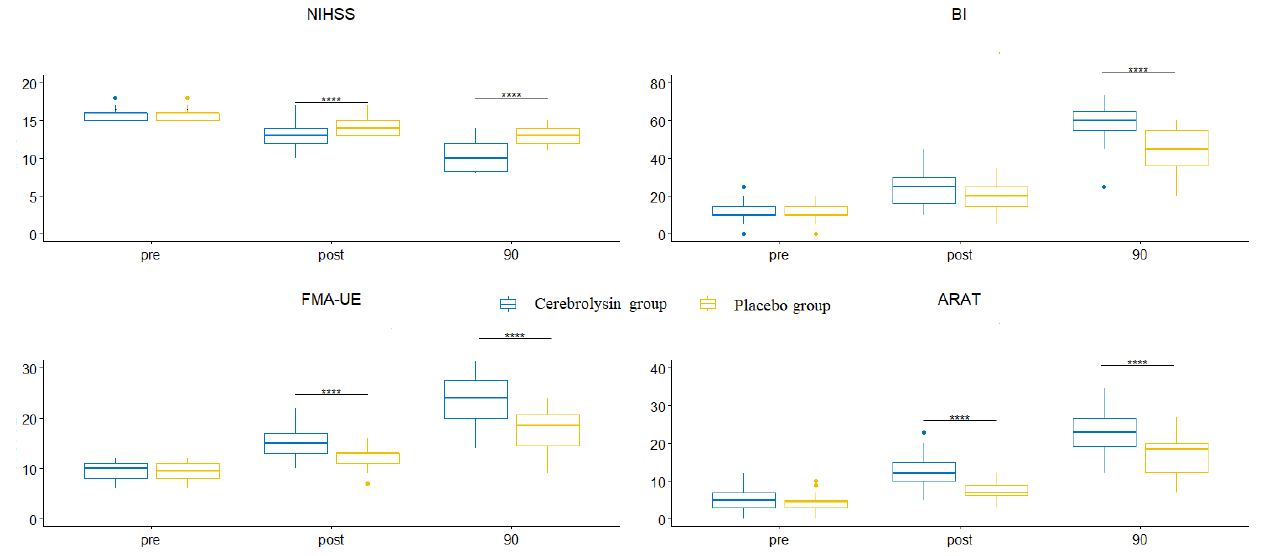
Figure 5. The comparisons in time points between groups in NIHSS, BI, FMA-UE and ARAT. **** p < 0.0001.